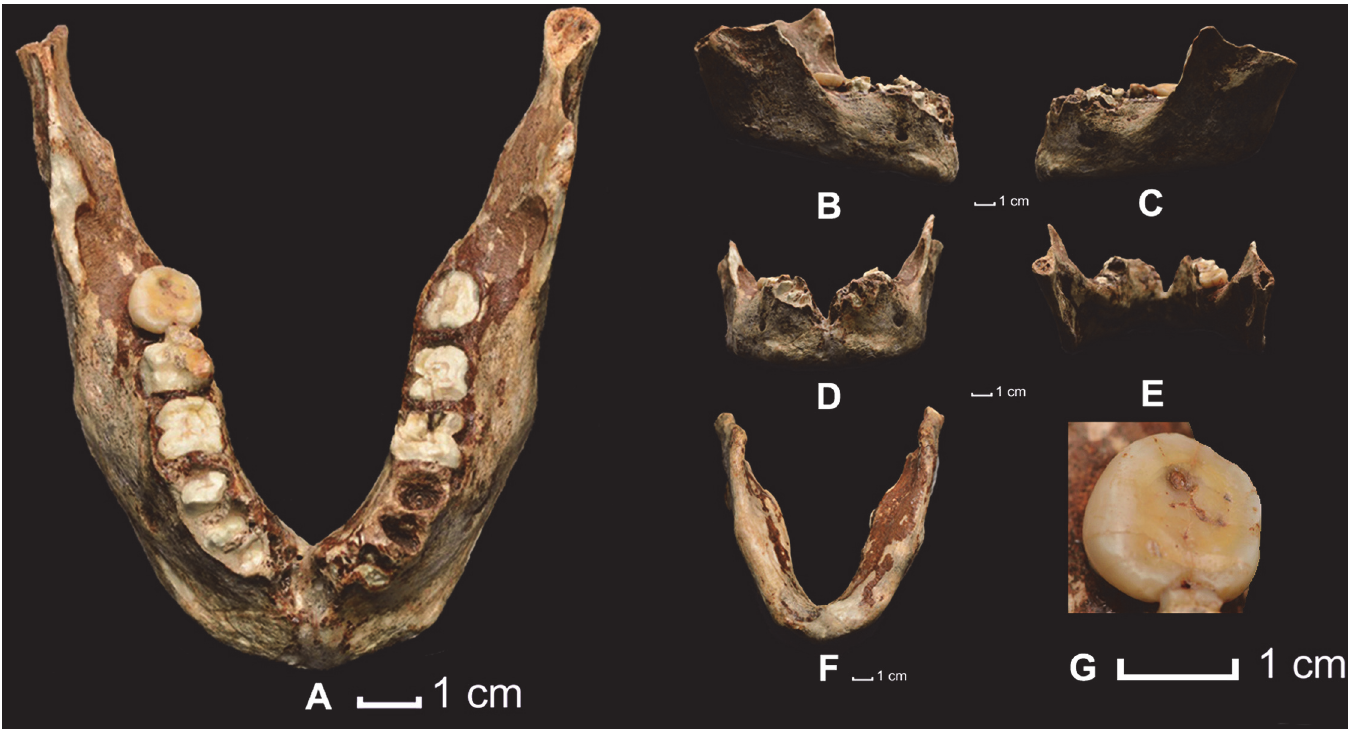
Fig 2. Human fossil remains designated as TPL2. (A) Mandible in norma verticalis ; (B) mandible in norma lateralis , right side; (C) mandible in norma latelaris , left side; (D) mandible in norma facialis external; (E) mandible in norma facialis internal (F) mandible in norma basilaris ; (G) occlusal view of the right M 3